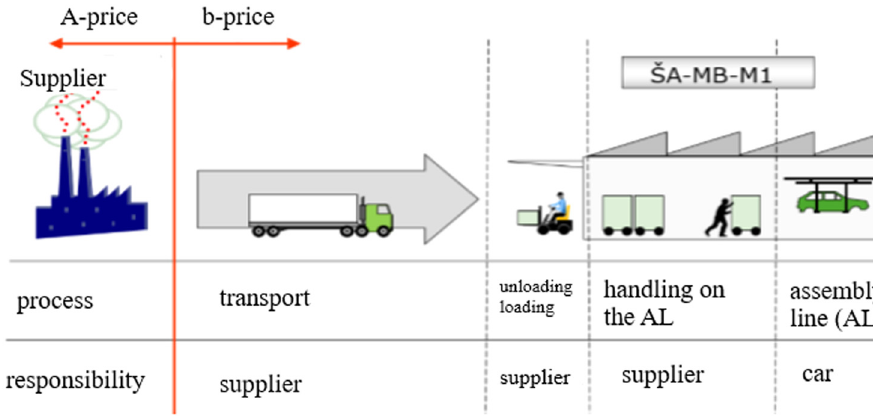
Figure 4: JIS A diagram. Internal source: LK 001 - 18 - 01 LAH